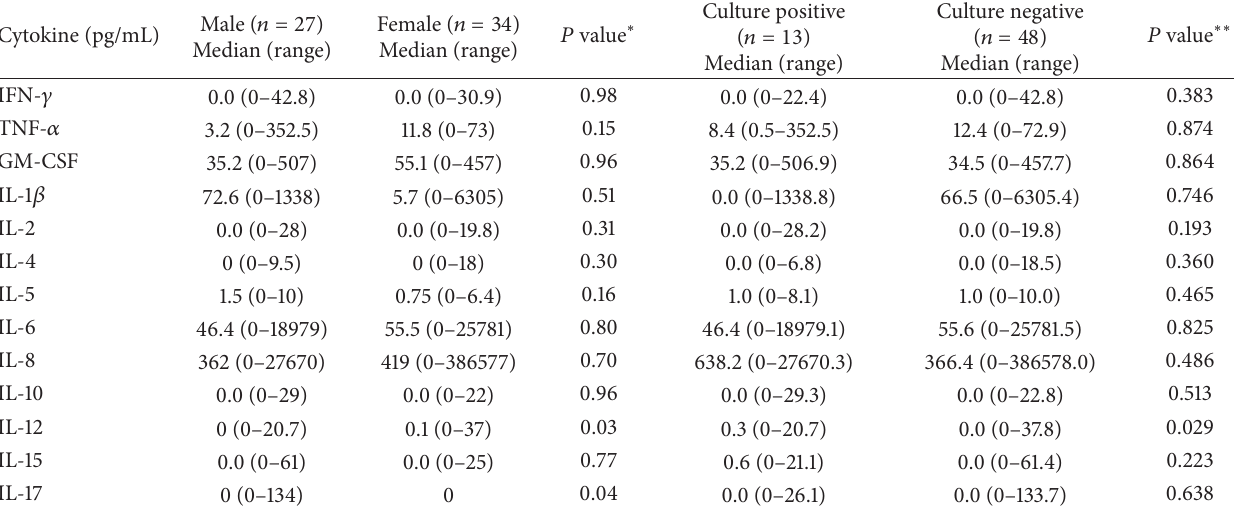
Table 5: Differences in the serum cytokine levels in the adult Tanzanian patients based on gender and mycobacterial culture from lymph